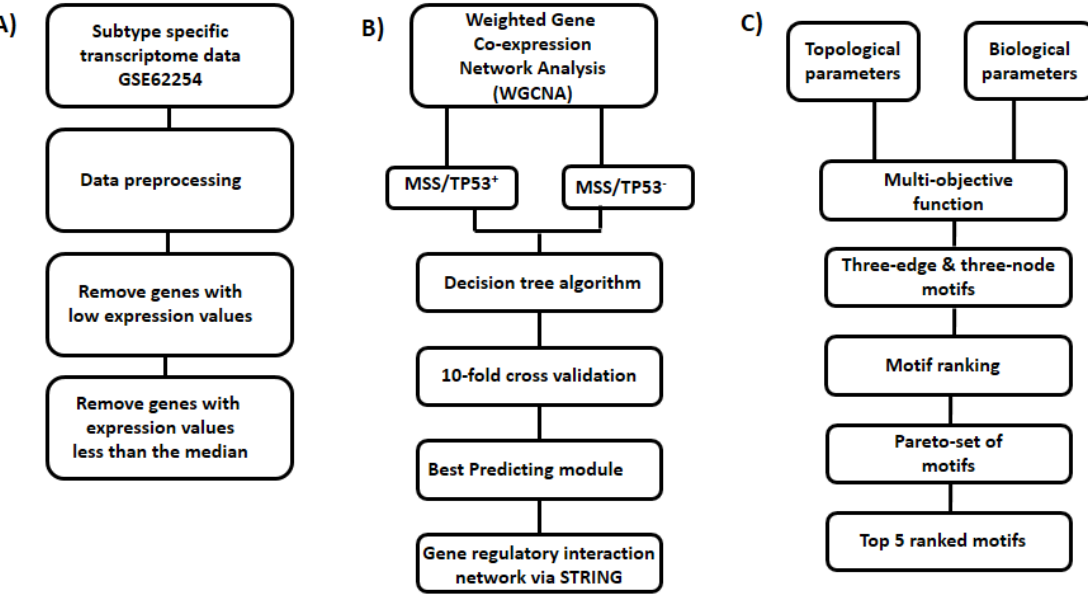
Fig. 1. Data analyzing workflow: Panel (A) shows the steps involved with data preprocessing including data normalization and feature filtering for GC subtype MSS/TP53 + and MSS/TP53; Panel (B) shows the construction of weighted gene co-expression network and the steps of model tuning. The data is split into training and test sets. Models are tuned based on the training set and evaluated using the test set. Modules which best predict clinical trait using decision tree were selected and gene regulatory network analysis was performed, respectively; Panel (C) contains the motif exploring and motif ranking